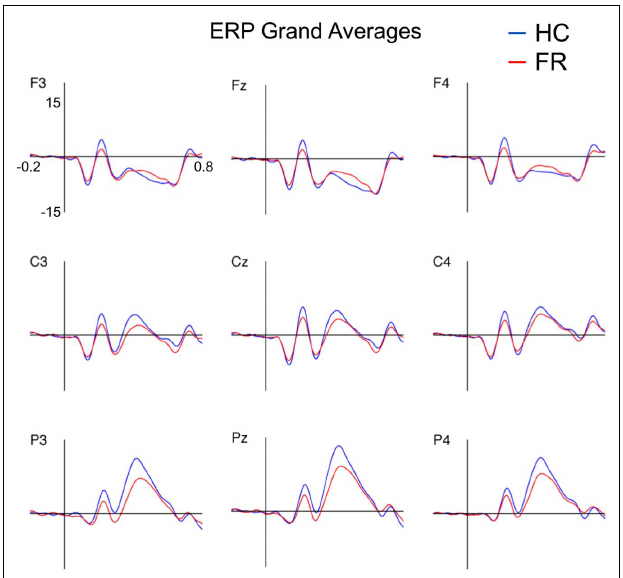
FIGURE 1 | Grand-average event-related potentials to targets (15Hz low-pass filtered) for the healthy control (HC) and familial risk (FR) groups for electrodes F3, Fz, F4, C3, Cz, C4, P3, Pz, and P4. Amplitude is indicated on the y -axis and ranges from + 20 to − 10 μ V (positive plotted upward).Time is indicated on the x -axis and ranges from − 0.2 to 0.8s. Target onset is at time =